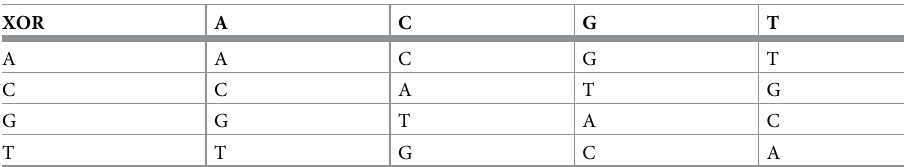
Table 5. DNA XOR.